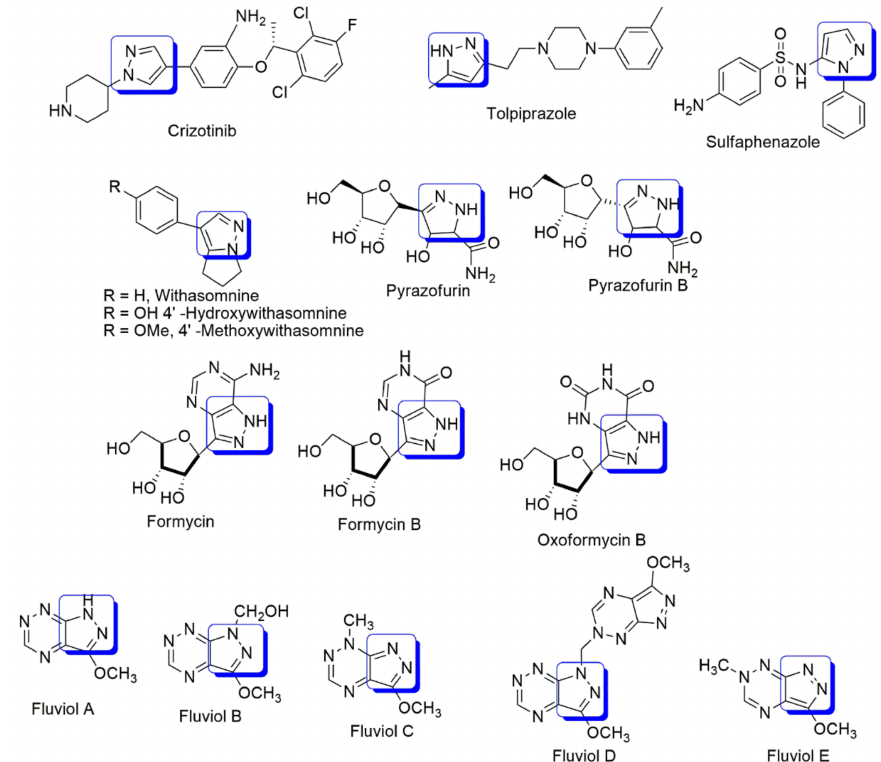
Figure 1. Naturally occurring bioactive compounds containing the pyrazole scaffold.